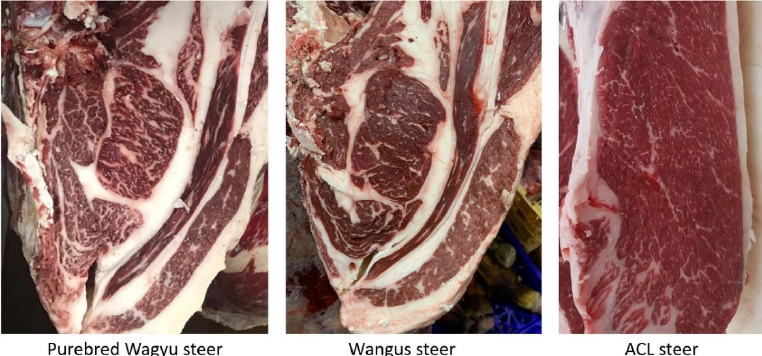
Figure 5. Marbling of beef of the different breed groups: pure bred Wagyu steers, Wagyu by Angus crossbred animals (Wangus), and crossbreeds of Angus with Charolais and Limousin (ACL).